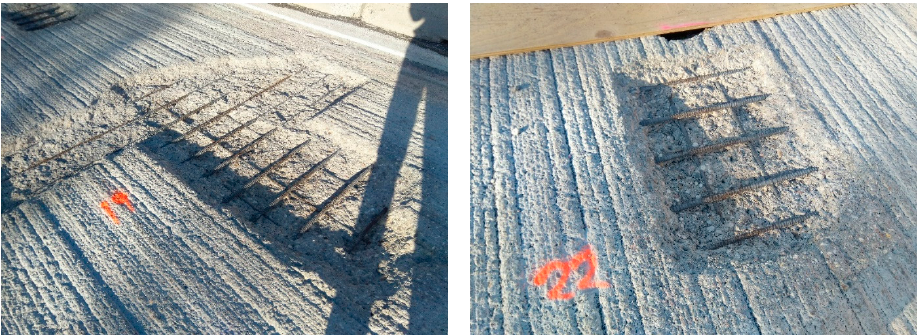
Figure 19. Images showing corroded parts of deck for validating GPR signals.